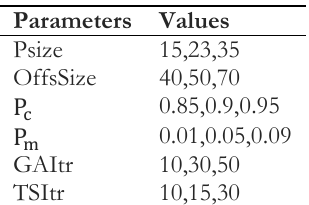
Table 8. List of MO-TS-GA parameters and their values.